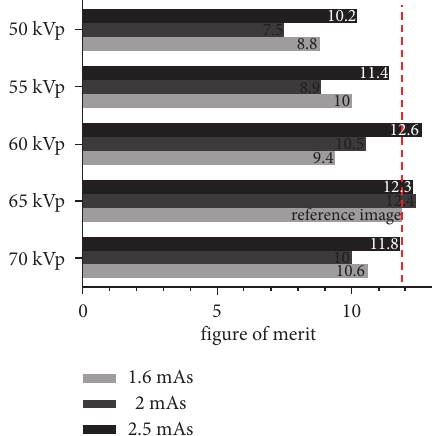
Figure 5: Result of the figure of